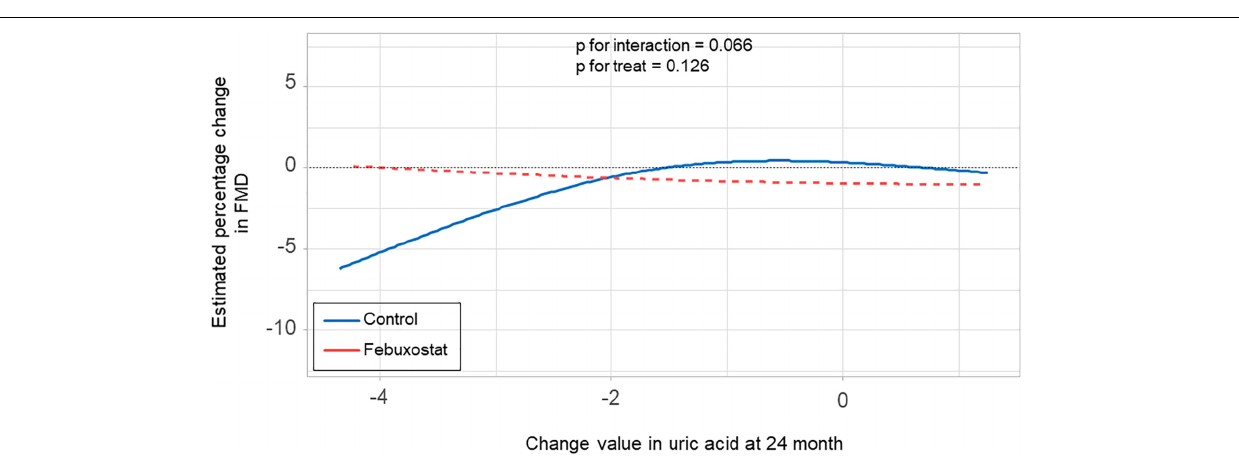
FIGURE 5 | Relationship between estimated percentage change in flow-mediated vasodilation (FMD) and change in serum uric acid levels at 24 months in the febuxostat group and the control group adjusted for baseline